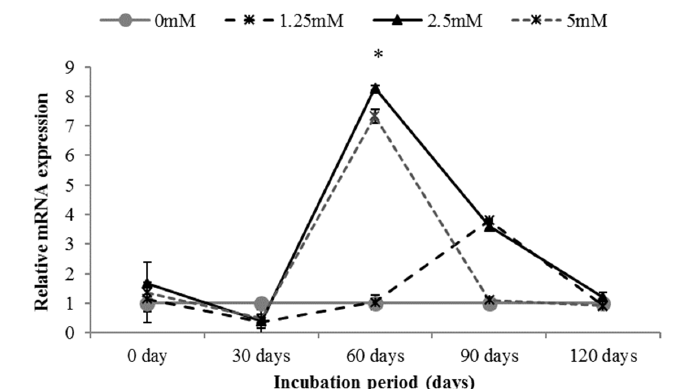
Figure 5. mRNA expression profile of nif H gene in Psuedomonas mendocina S10 inoculated in soil treated with ammonium concentrations 0 mM, 1.25 mM 2.5 mM, and 5 mM Each data point represents mRNA abundance of nif H gene normalized to 16S rRNA, which was used as a housekeeping gene. One-way ANOVA determined the significance of difference. Each data point represents mean and the vertical line on it indicates the standard error. The asterisk shows significance level: p<0.05 with 0-day samples